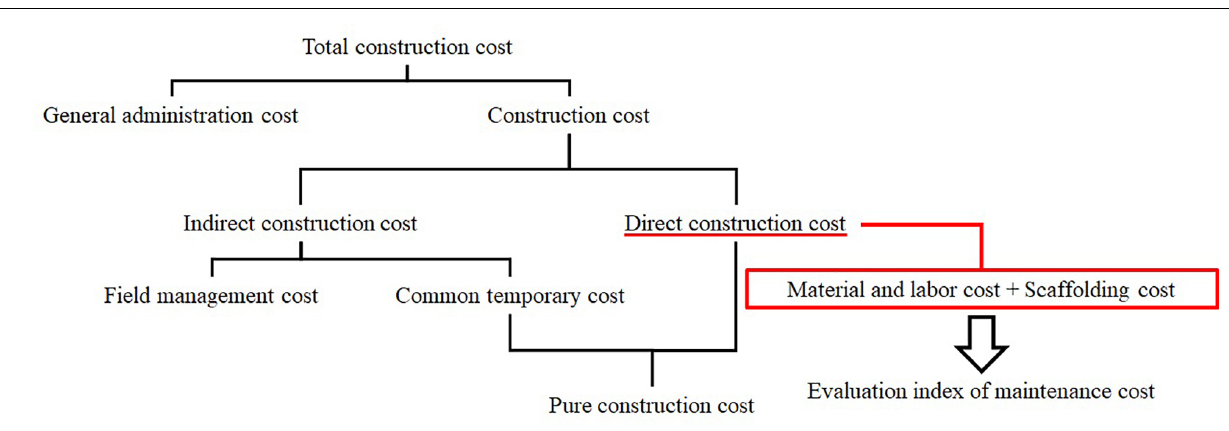
FIGURE 4 | Example of degradation.